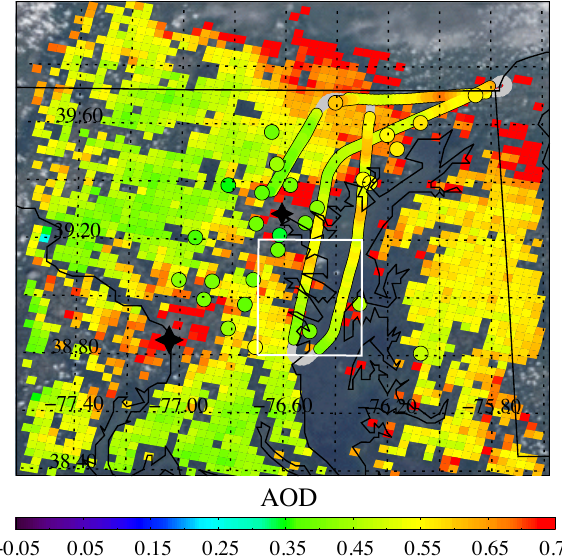
Fig. 3. A 3km resolution AOD at 0.55µm observed by MODIS- Terra on 29 July 2011 at 16:00UTC is plotted in the background. HSRL 532nm columnar AOD along the flight track between 15:30 and 16:30UTC is shown in the thick line. SP AOD interpolated to 0.55 µm is shown in the circles. The SP measurements are not temporally averaged; the nearest measurement to 16:00UTC is shown, provided the measurement was taken between 15:30 and 16:30UTC. Washington D.C. is shown with the large black star and Baltimore, MD is shown with the small black star. The true color image, created from the MODIS red, green and blue bands, is shown in the